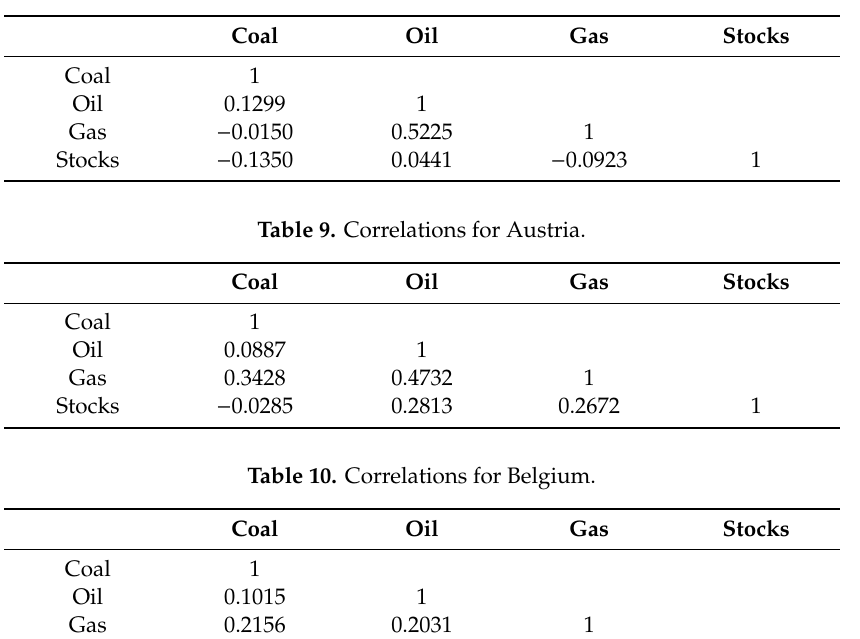
Table 8. Correlations for Japan.